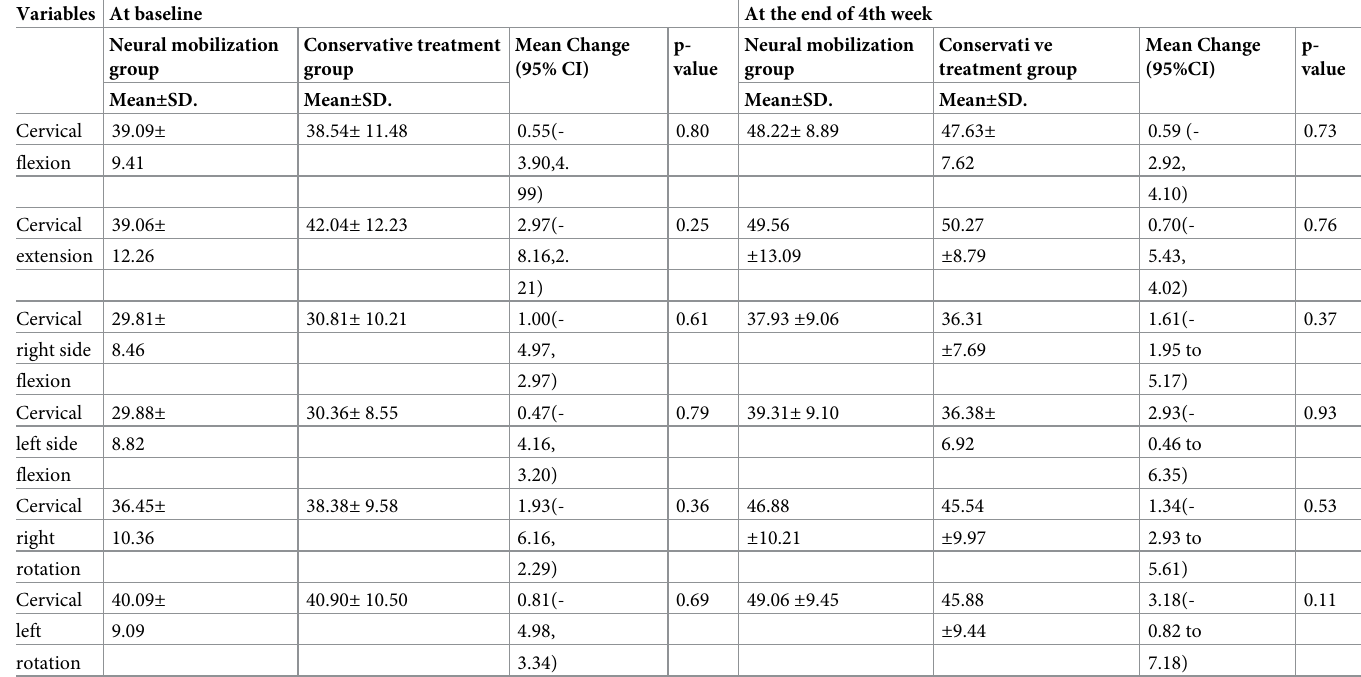
Table 6. Comparison of cervical range of motion between experimental and control